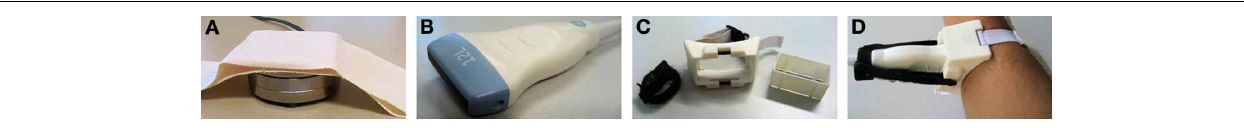
FIGURE 2 | Parts of the setup. (A) ATI Mini45 force sensor, fixed to the table. The subjects press on its top; (B) linear ultrasound transducer GE 12L-RS; (C) custom-made transducer cradle, disassembled; (D) transducer attached onto a subject’s forearm, using the cradle.